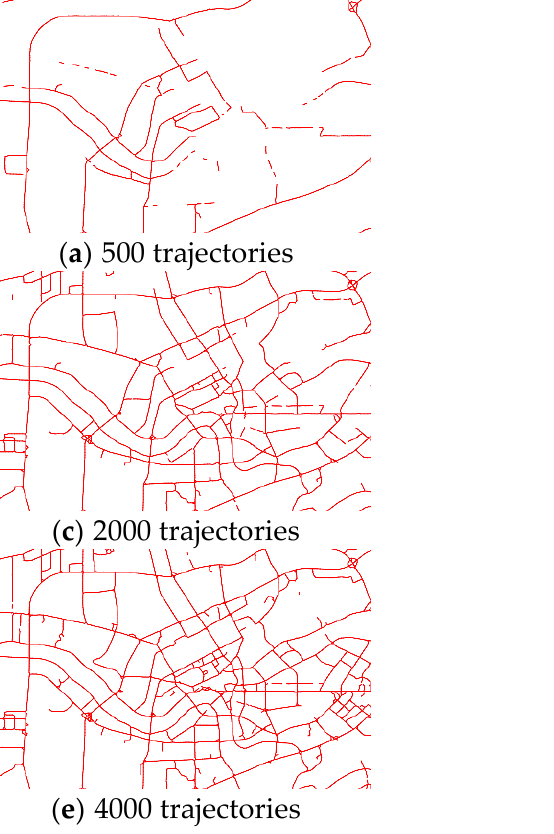
Figure 14. Road networks generated by different numbers of trajectories